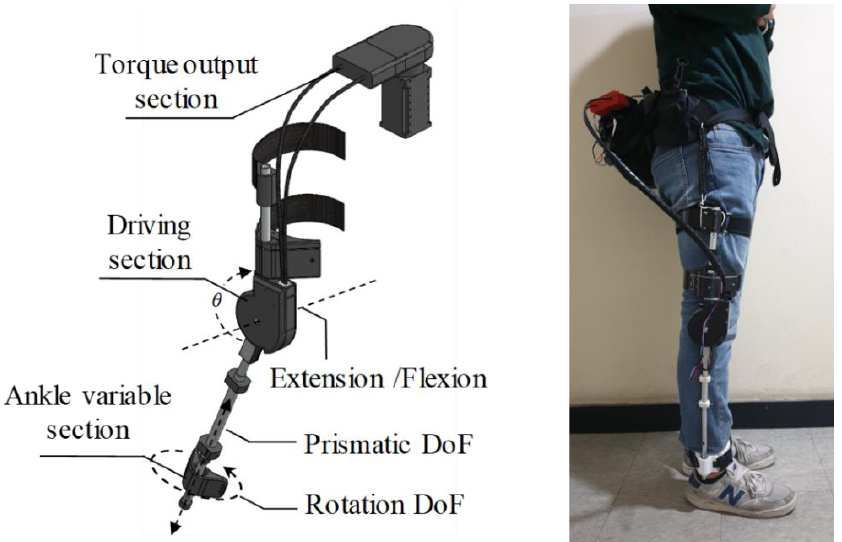
Figure 2. The overall appearance ( left ) and actual appearance ( right ) of the exoskeleton. The exoskeleton has three DoFs: two on the ankle and one on the knee. The knee angle is given as θ . The lower frame length of the exoskeleton could be changed so that the center axis of the knee rotation and the axis of rotation of the exoskeleton could be matched. Thus, fully seated motion is possible.